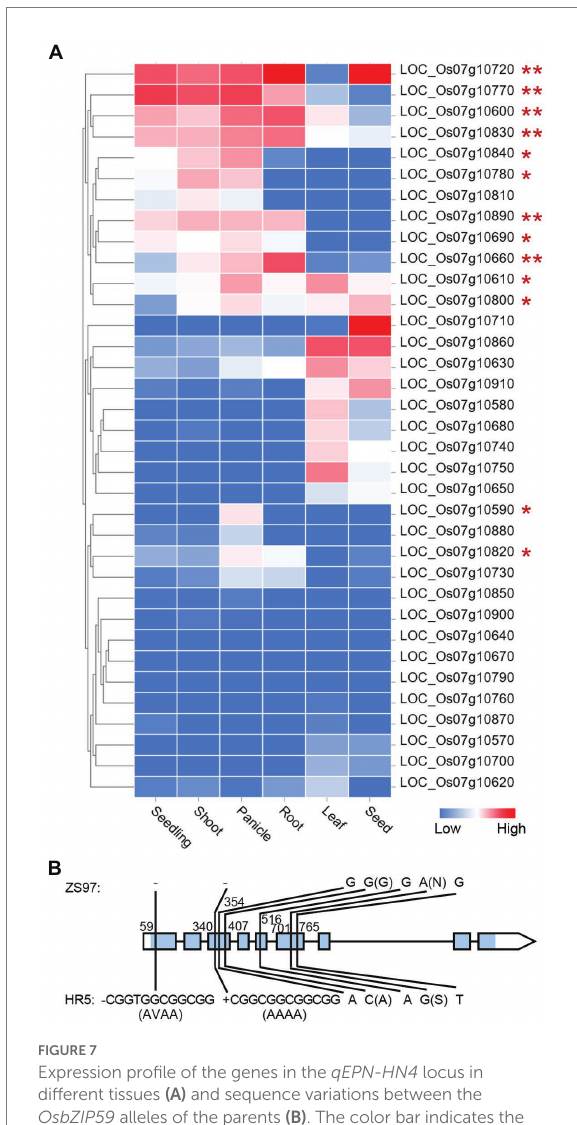
FIGURE 7 Expression profile of the genes in the qEPN-HN4 locus in different tissues (A) and sequence variations between the OsbZIP59 alleles of the parents (B) . The color bar indicates the relative expression levels. The genes are clustered according to their tissue expression profiles. The genes expressed in both or either the panicle and root are marked by ** or *. The blue rectangle in the gene model indicates the coding region. The relative positions to the start codon of the variations are shown. The amino acid changes induced by non-synonymous mutations are indicated in the brackets. Only the variations in the exons are